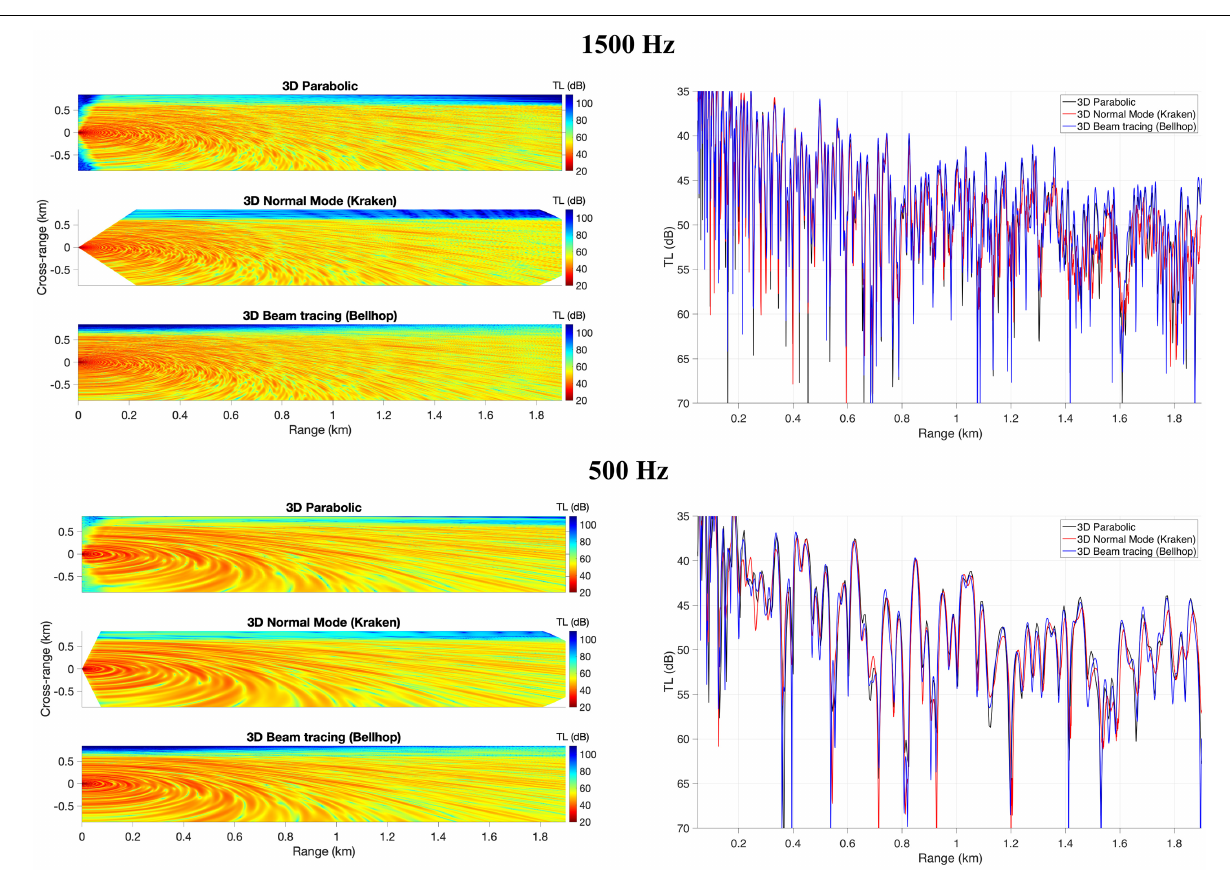
FIGURE 4 | Comparison between 3D parabolic, 3D normal mode (Kraken, no mode coupling), and 3D beam tracing (Bellhop) for the shallow water wedge problem. Results present TL at 20 m depth for a 1500 Hz (top panel) and 500 Hz (bottom panel) sound source for an isovelocity ( c 0 = 1500m / s) waveguide. Plots on the right present TL at cross-range =